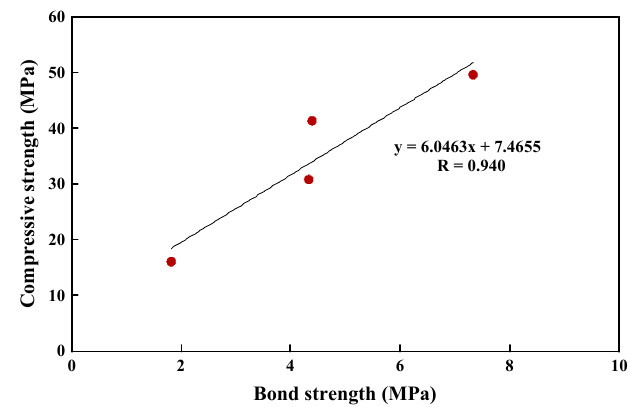
Figure 11. Relationship between compressive and bond strengths.